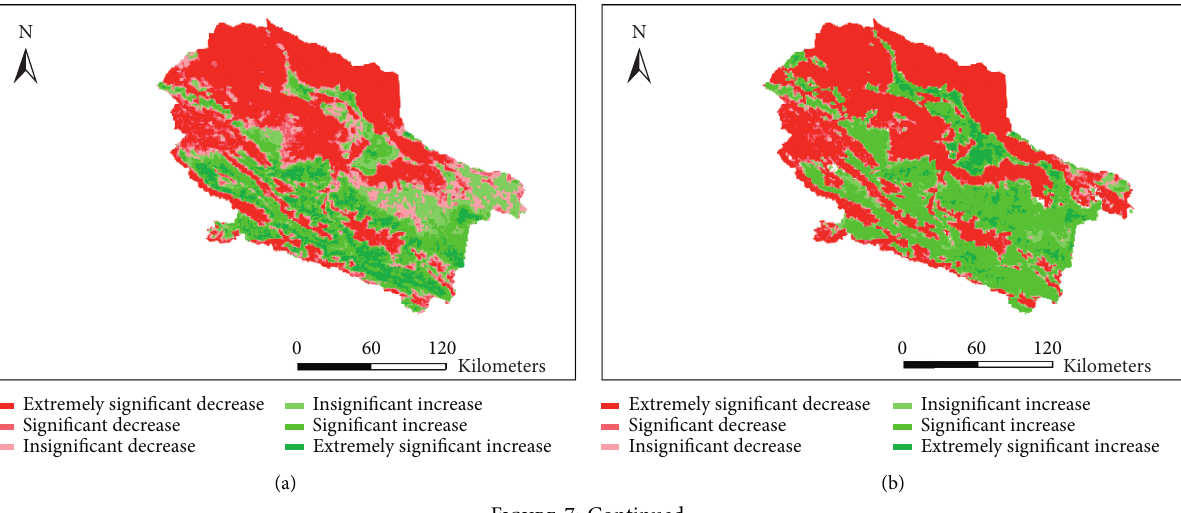
Extremely significant decrease Significant